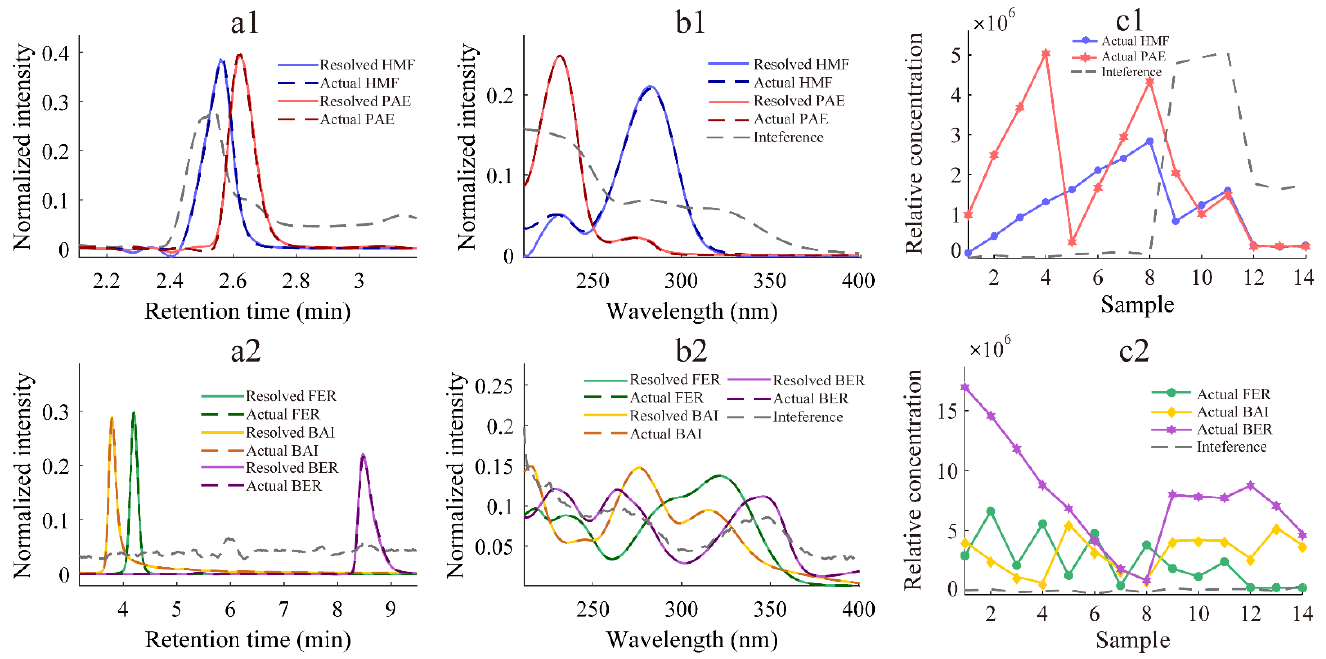
Figure 2. The normalized chromatograms ( a1 , a2 ), the normalized spectrograms ( b1 , b2 ), and the relative concentration profiles ( c1 , c2 ) resolved by the ATLD algorithm from two three-way subarrays.